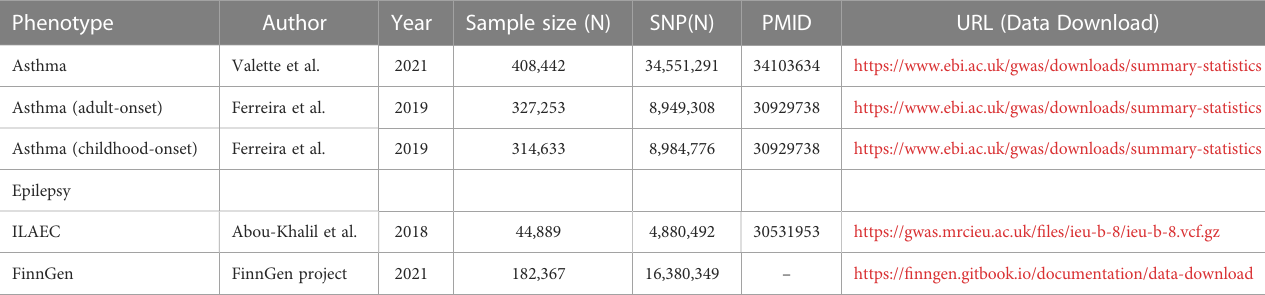
TABLE 1 Summary of the genome-wide association studies included in this Mendelian randomization study.